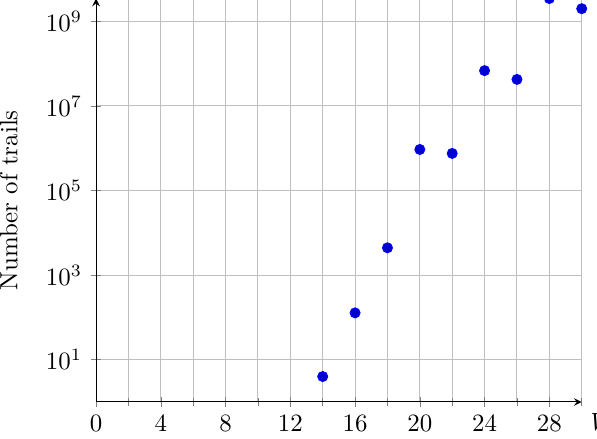
Figure 5: Number of active cells of two-round differential trails.